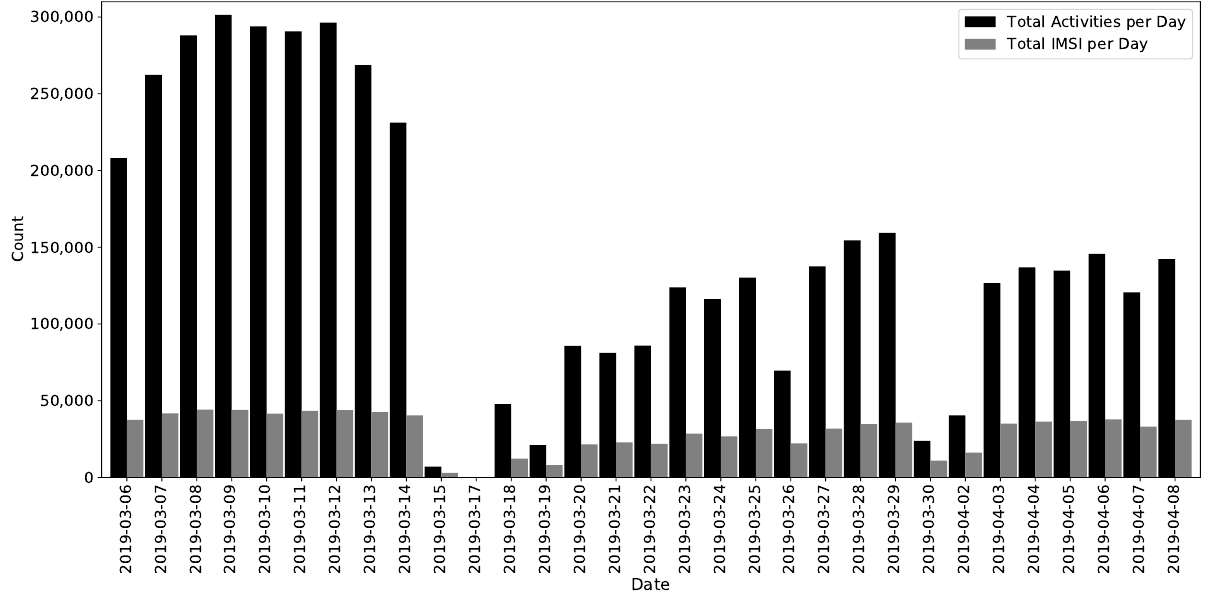
Figure 6. Total number of activities and IMSI per day in the study